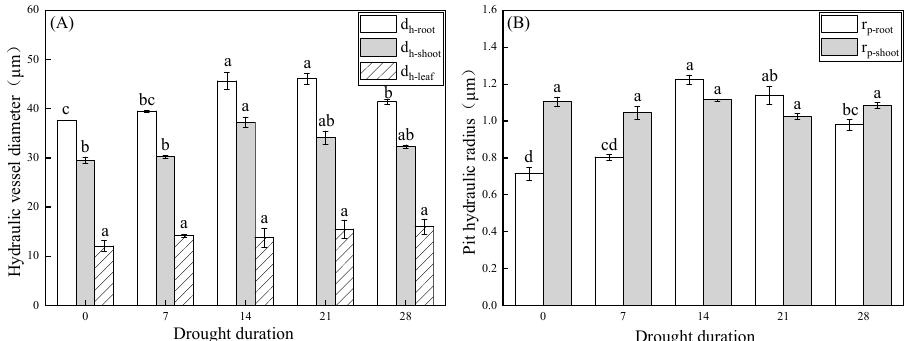
Figure 8. Vessel hydraulic diameter in xylem ( A ), and pit radius ( B ) in different drought treatments. ( A ): d h-root (open bars) indicate vessel hydraulic diameter of the root, d h-shoot (light-shaded bars) indicate vessel hydraulic diameter of the shoot, d h-leaf (hatched bars) indicate vessel hydraulic diameter of the leaf. ( B ): r p-root (open bars) indicate pit radius of the root, r p-shoot (light-shaded bars) indicate pit radius of the shoot. Different lower-case letters denote significance levels based on analysis of variance (ANOVA) post hoc means with least significant difference (LSD) analysis ( p < 0.05). Data are means with standard error.